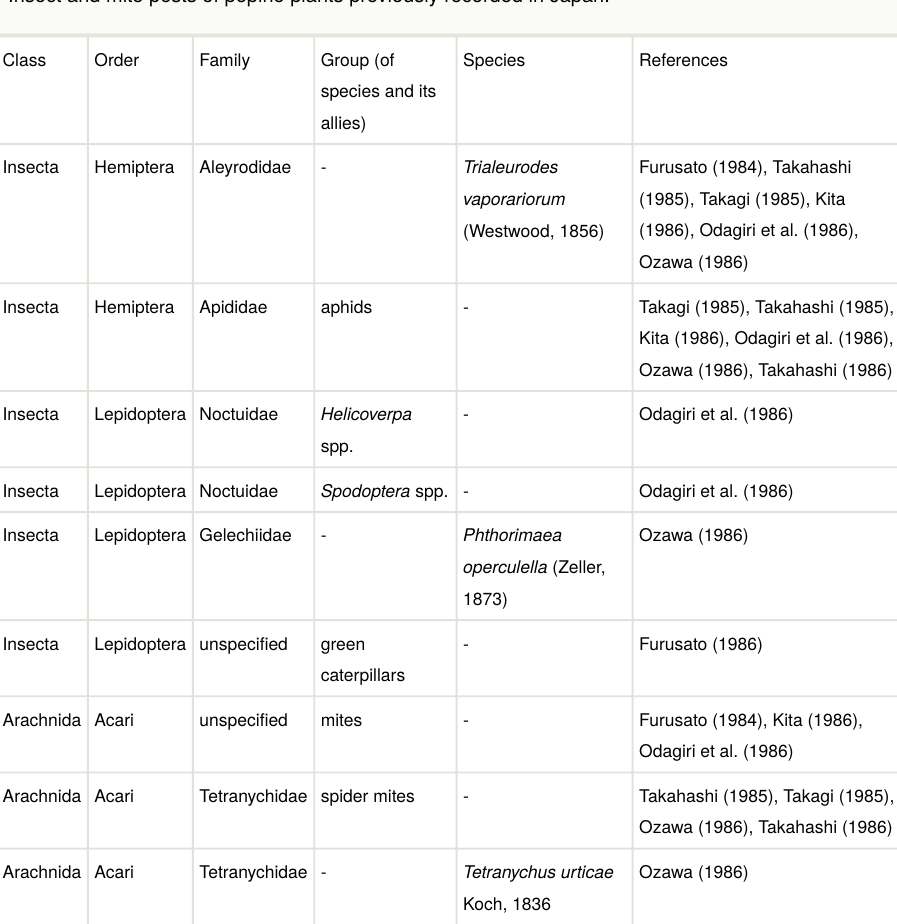
Insect and mite pests of pepino plants previously recorded in